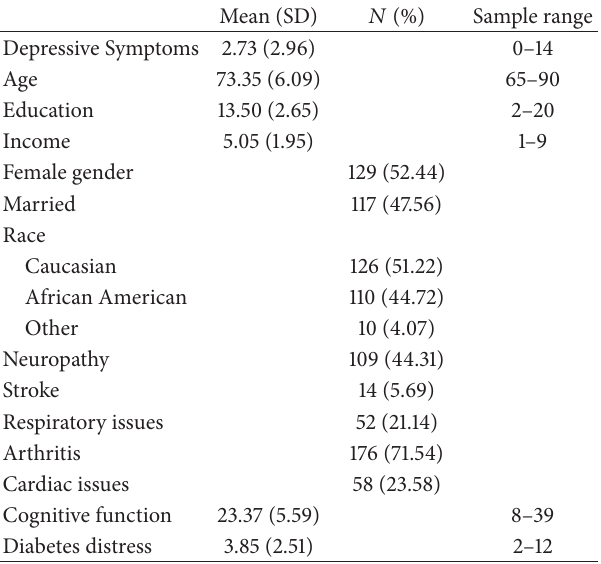
Table 1: Sample characteristics on study